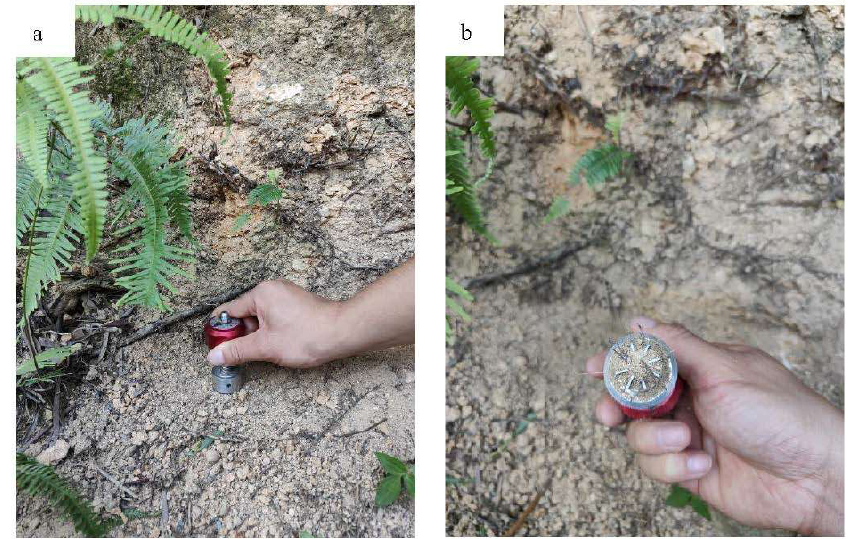
Figure 4. ( a ) Photo of the in situ direct shear test process; ( b ) photo after direct shearing.